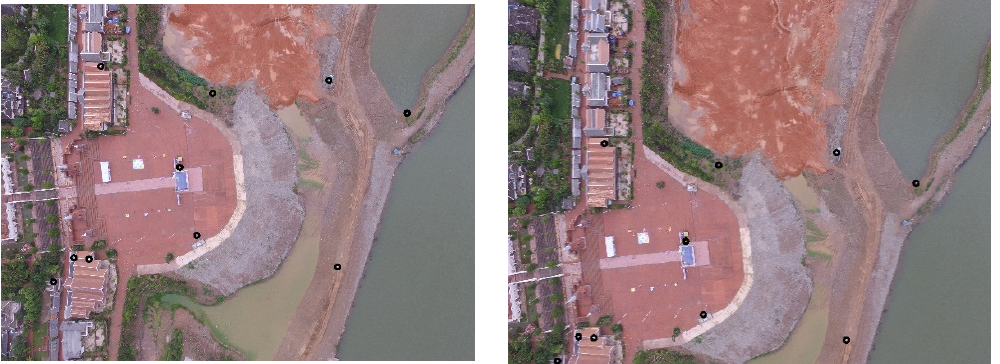
Figure 5. Manually selected feature points in two images.